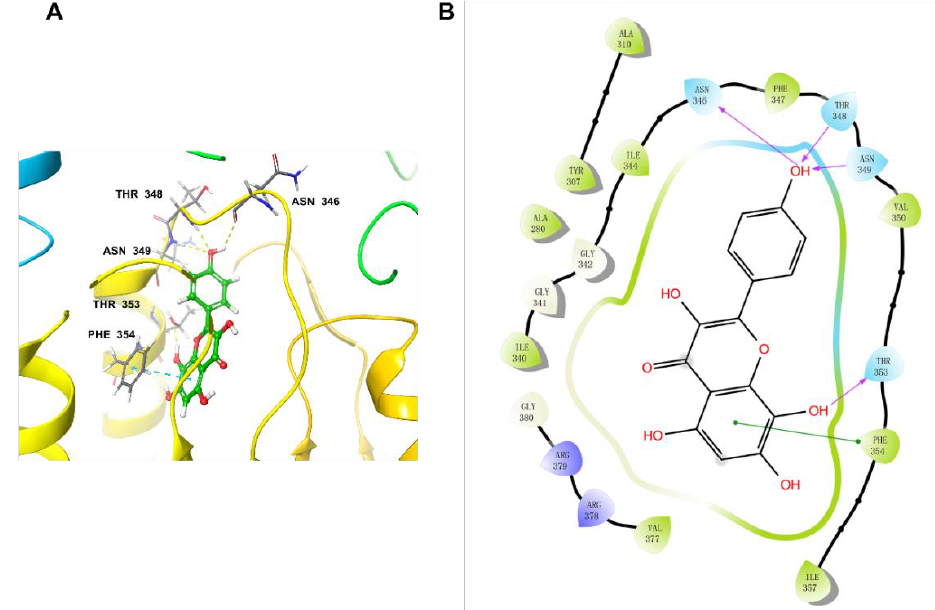
Figure 6. The docking pose of herbacetin binding to ACLY: ( A ) three–dimensional presentation of herbacetin on ACLY. Carbon atoms are shown in green, oxygen atoms are shown in red, and hydrogen atoms are shown in white; hydrogen-bond interactions were showed in dashed lines; and ( B ) two–dimensional presentation of herbacetin and ACLY. Hydrogen-bond interactions were marked with arrows.